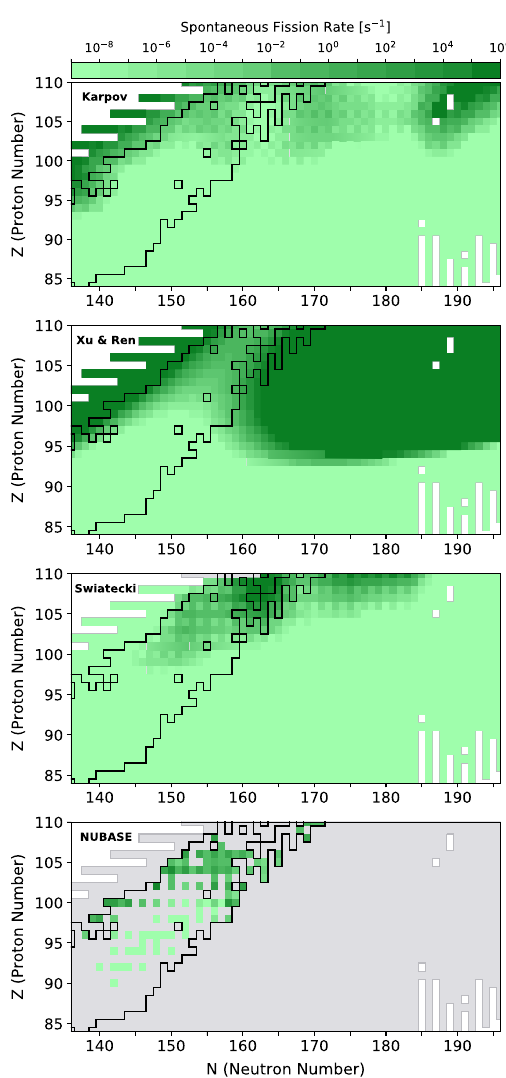
Figure 1. Spontaneous fission rates assuming FRLDM barriers [15] along with the phenomenological formula of Karpov et al. [16] (top panel) as compared to rates given by Xu & Ren [18] (second panel) and Swiatecki [17] (third panel) parameterizations. The bottom panel shows experimental rates given NUBASE2016 [19] half-lives and branching ratios for comparison. The black outline shows the extent of NUBASE half-life data and the grey region shows the FRDM2012 [20] neutron